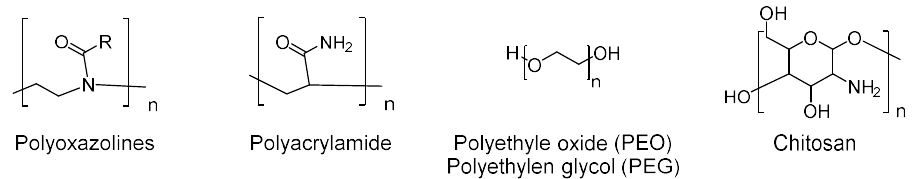
Figure 15. Chemical structure of some common monomers and polymers used for surface treatment.